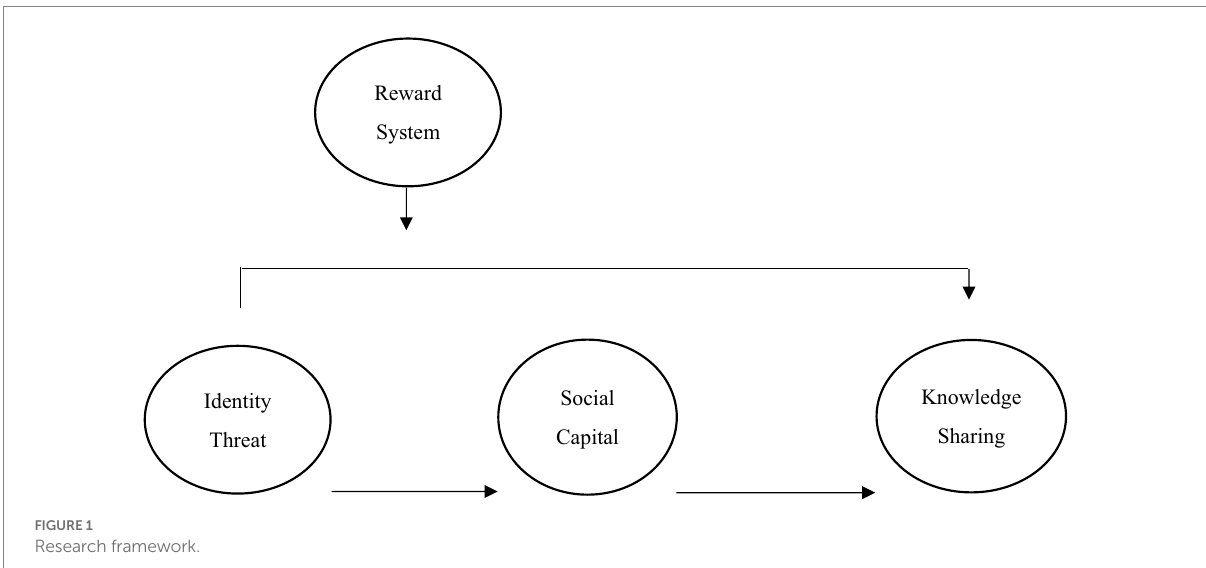
FIGURE 1 Research